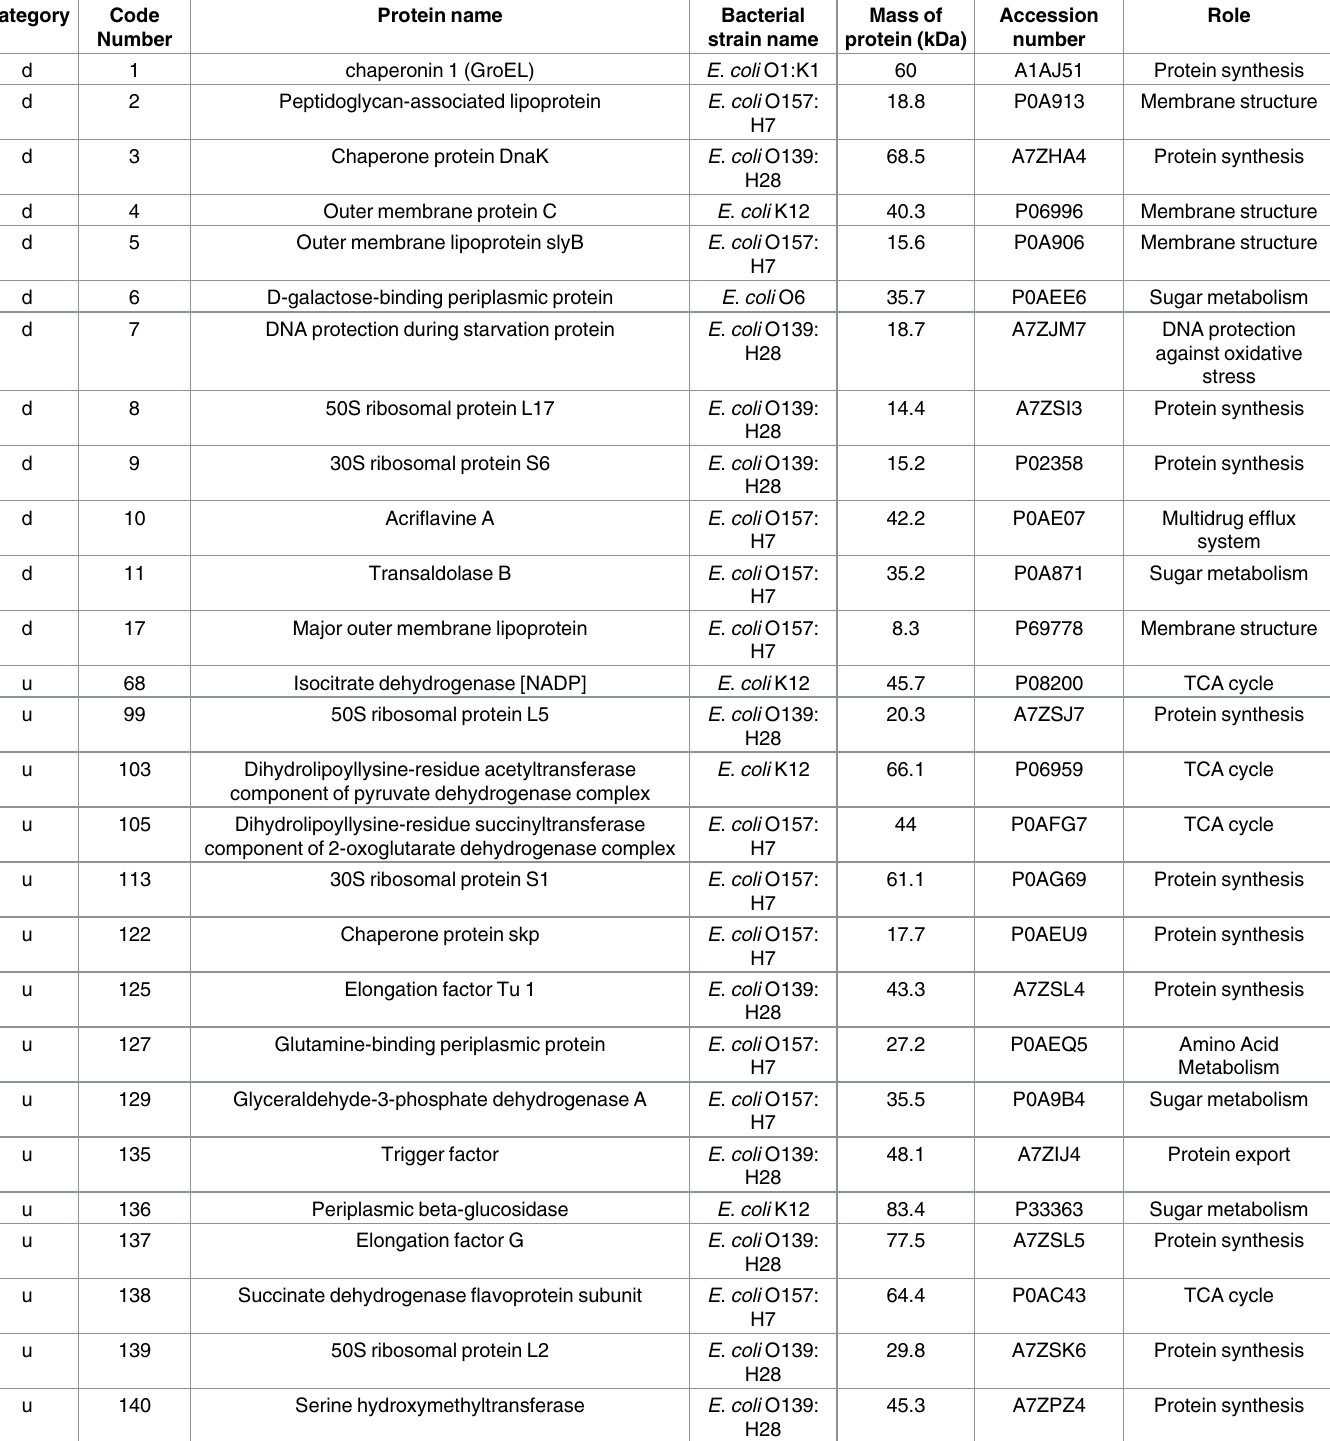
Table 1. Differentially expressed E . coli cellular proteins in response to treatment with titanium dioxide nanoparticles. Code numbers correspond to the names of those proteins whose score significantly decreases or increasesin responseto the treatment of the bacterial cells with TiO 2 nanoparticles. These proteins fall into two categories, those consideredas significantly down-regulated (d) and those significantly up-regulated (u) in the presenceof nanoparticles.